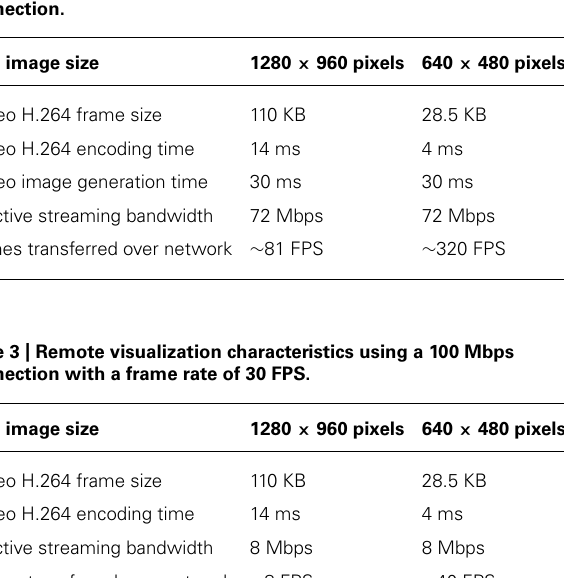
Table 2 | Remote visualization characteristics using a gigabit Ethernet connection.